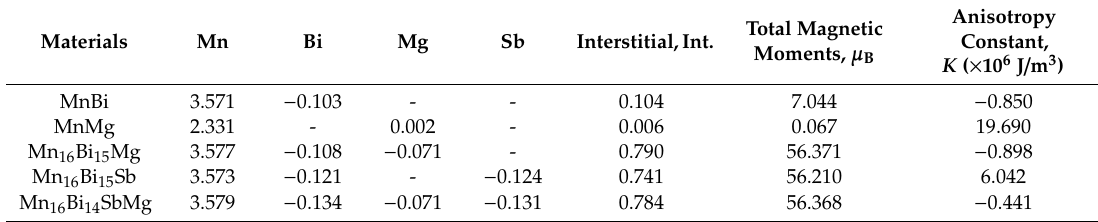
Table 1. Calculated Mn, Bi, Mg, Sb, interstitial, and total magnetic moments and anisotropy